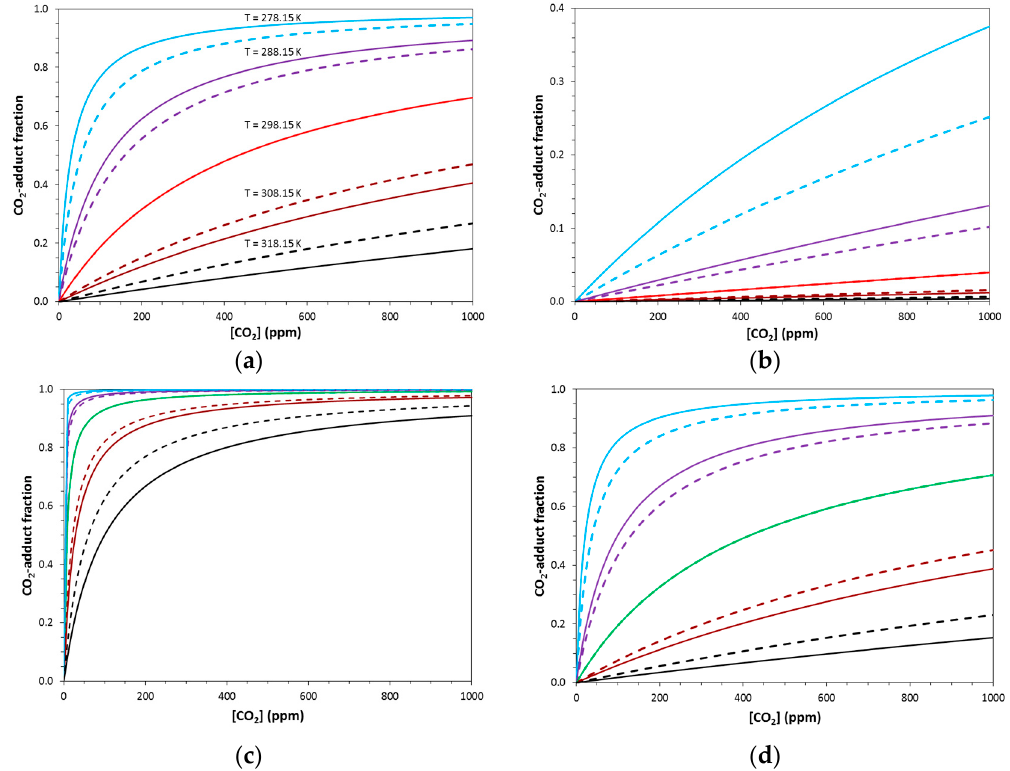
Figure 3. Equilibrium concentrations of complexed product of a general capture reaction (GCR) ( left ) and a rubisco-type capture reaction (RCR) ( right ) at five temperatures from 278.15 to 318.15 K. The color of the central curve (298.15 K) corresponds to the same system in Figures 3 and 4. Panels ( a ) and ( b ) describe the thermochemistry of R14a with Δ G ° = − 6.59 kcal/mol, Δ H ° = − 17.26 kcal/mol, and Δ S ° = − 35.81 cal/(mol·K). Panels ( c ) and ( d ) describe the thermochemistry of R14h with Δ G ° = − 9.00 kcal/mol, Δ H ° = − 19.67 kcal/mol, and Δ S ° = − 35.79 cal/(mol·K). Solid lines were computed with T -dependence of Henry’s Law and dashed lines were computed without.